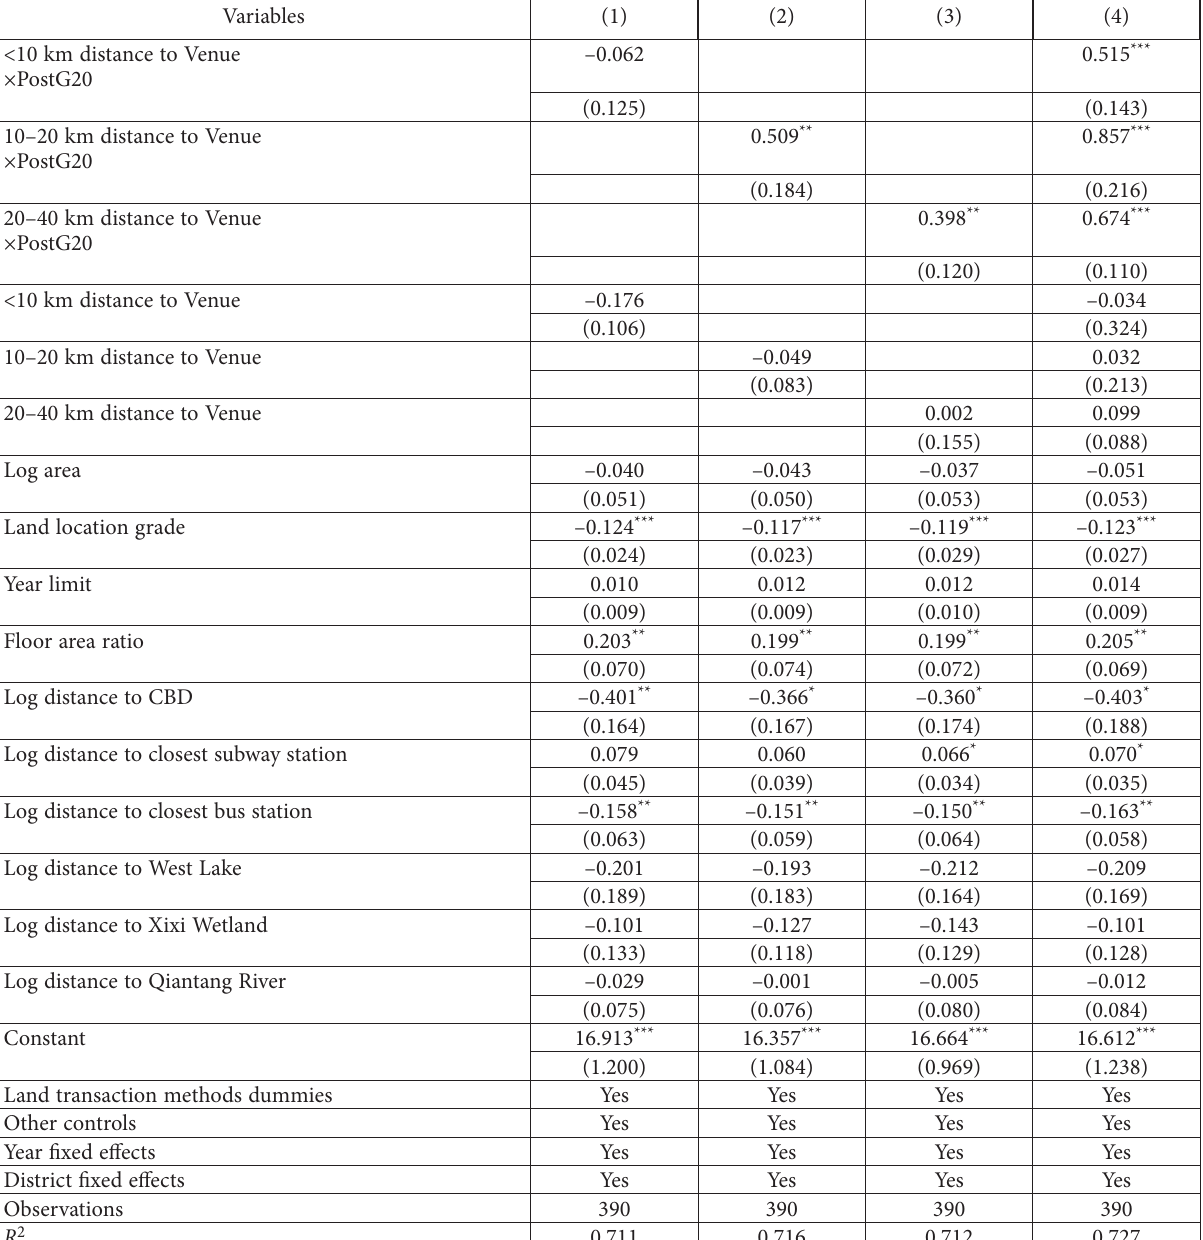
Table 8. Effect of G20 main venue construction on land